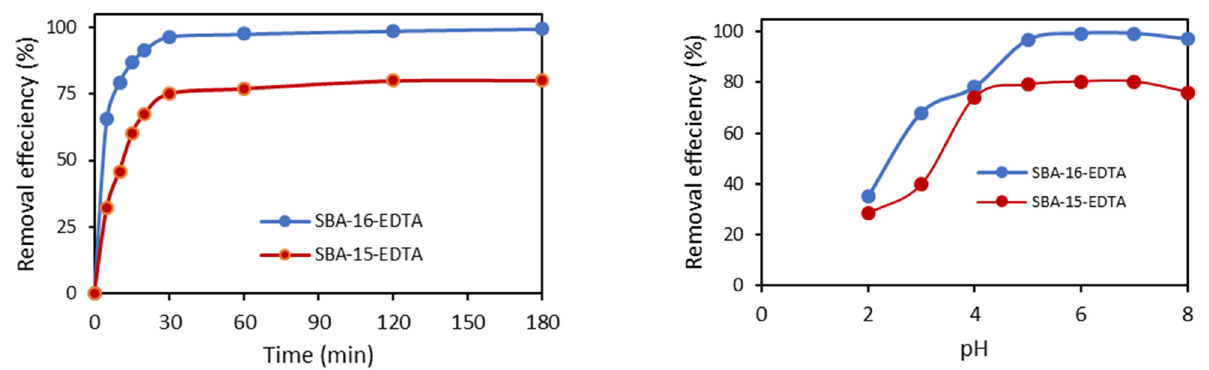
Figure 9. Effect of contact time and pH on Zn 2+ on EDTA-modified SBA-16 and SBA-15 (at RT and [Zn 2+ ] i = 30 ppm).